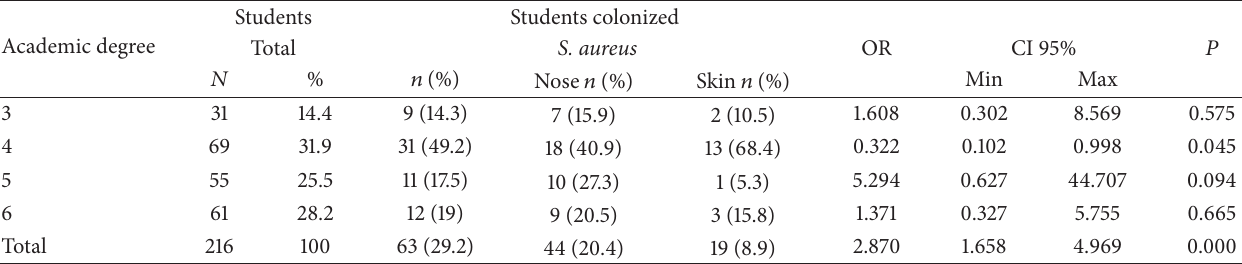
Table 1: Frequency of isolation of S. aureus from medical